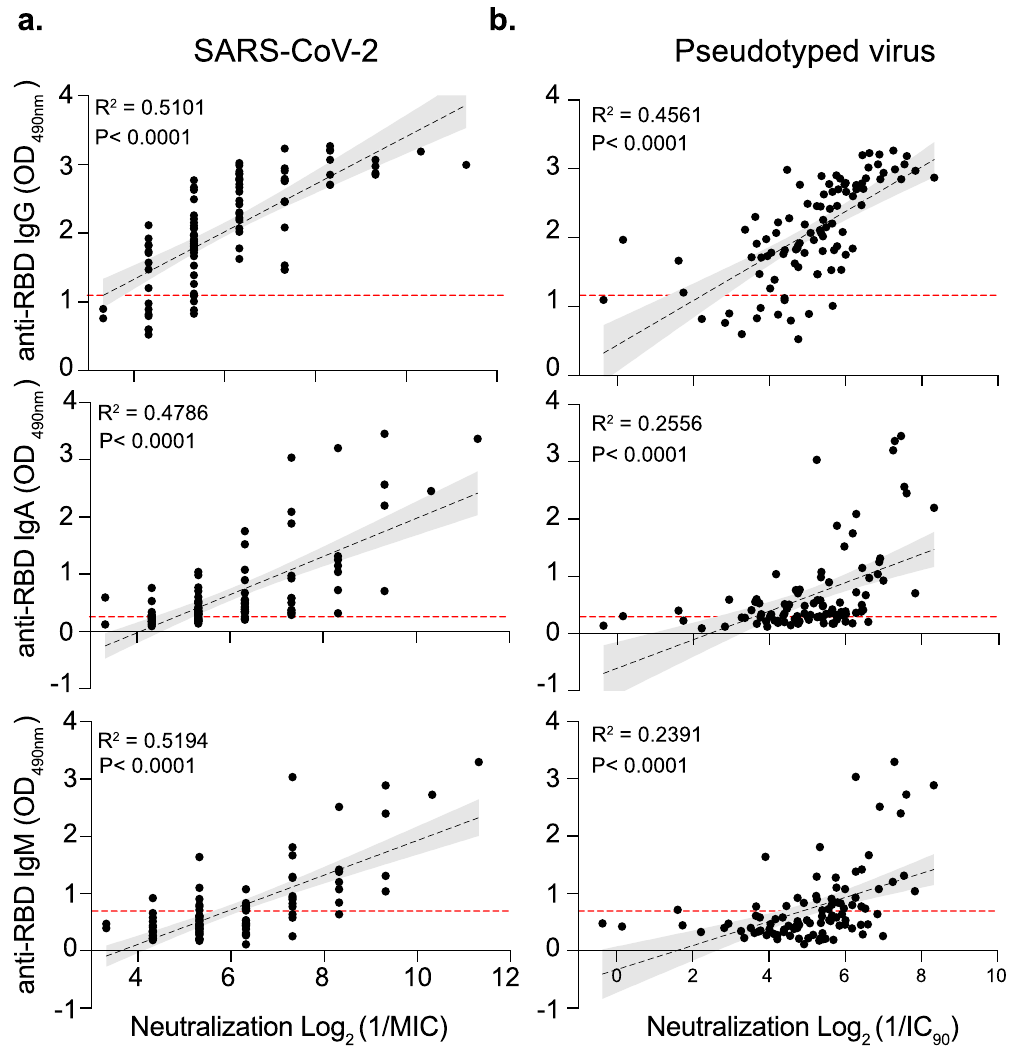
Figure 3. Correlation of anti-RBD antibody isotypes with viral neutralization. Anti-RBD ELISA correlation for IgG (top), IgA (middle) and IgM (bottom) with viral neutralization using authentic SARS-CoV-2 ( a ) or Pseudotyped virus ( b ). Correlation and linear regression analyses were performed using GraphPad Prism 8. P values were calculated using a two-sided F test. The red dashed lines indicate the threshold (anti-RBD ELISA for -IgG is OD490nm = 1.091; -IgA is OD490nm = 0.256 and -IgM is OD490nm = 0.694) for each